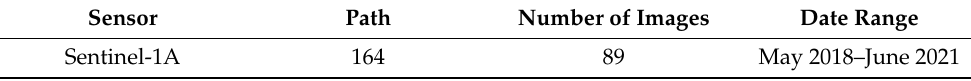
Table 1. SAR datasets.